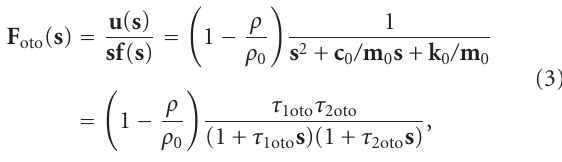
Figure 4: (a) Visualization of the diagnosis procedure, (b) Di ff erent coordinate systems: R 0 : ( O ,